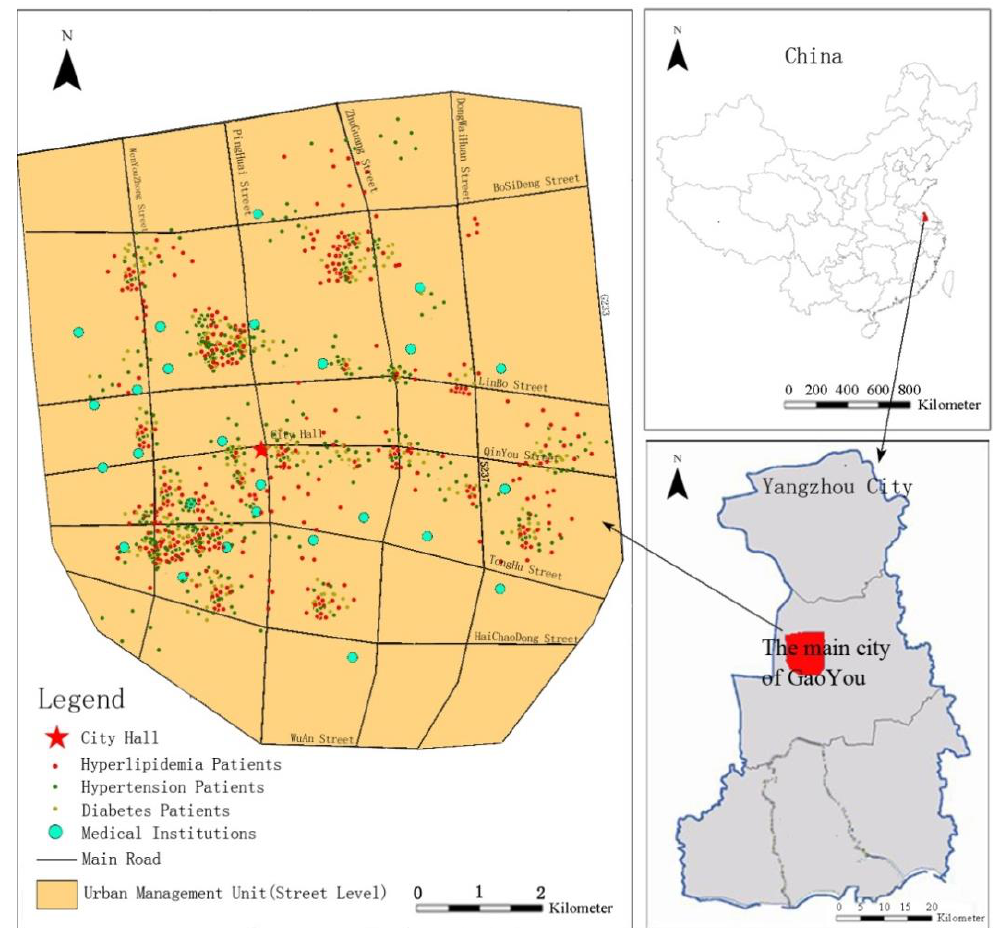
Figure 2. Location of Gaoyou and the study area